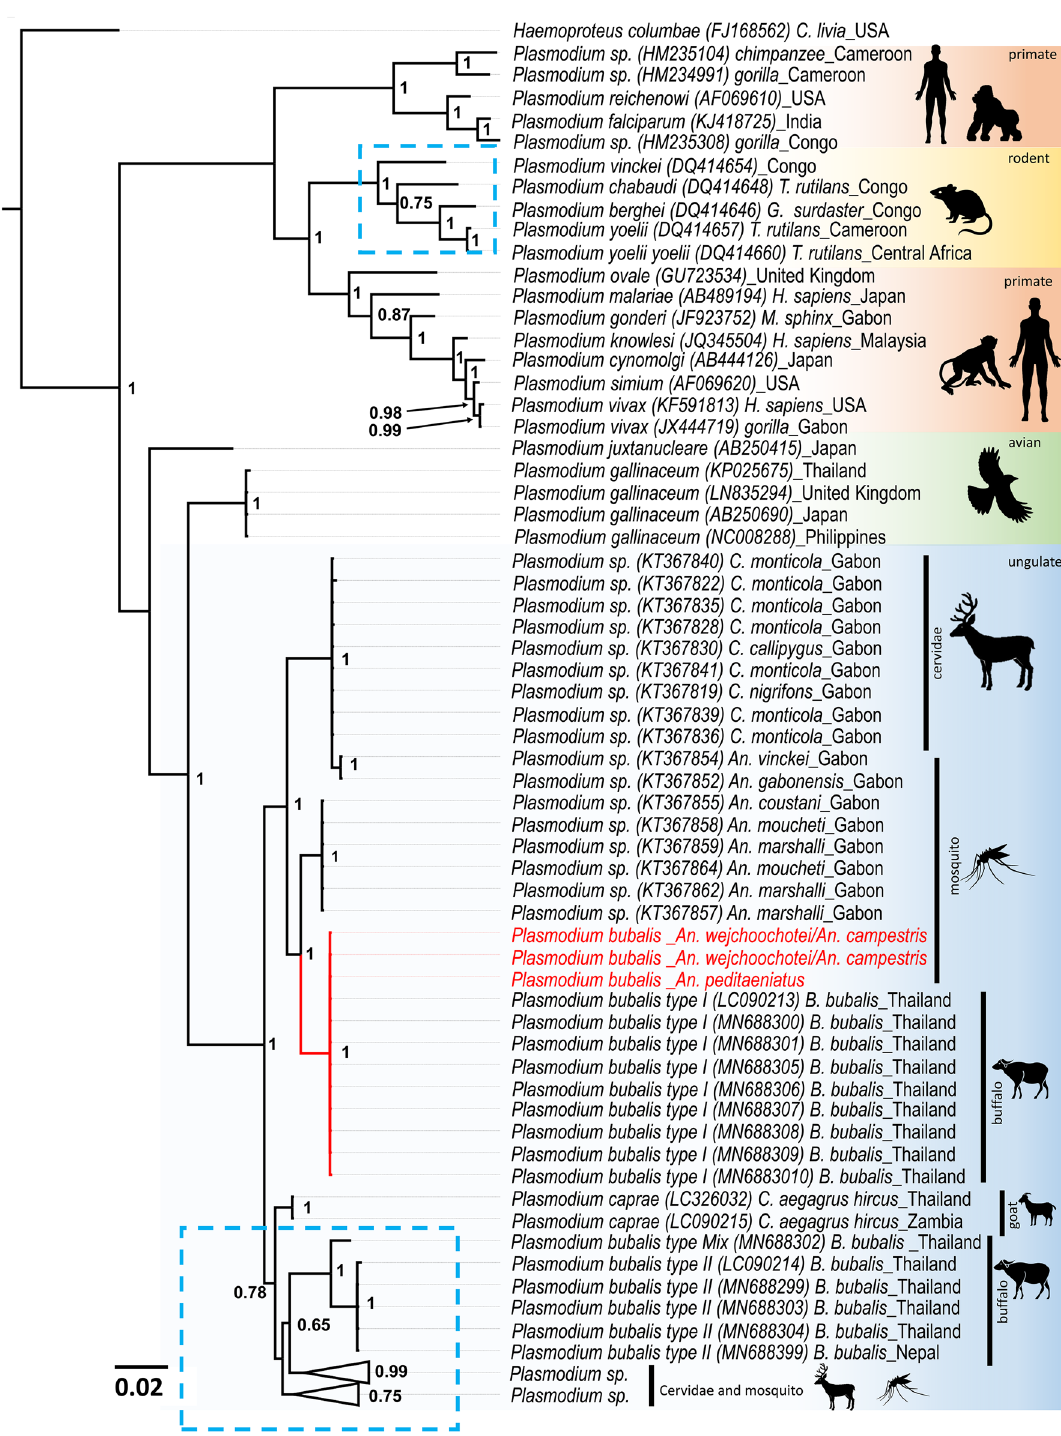
Figure 3. ( A ) Map depicting a buffalo farm in Chachoengsao for sample collection in Thailand. ( B ) The landscape of mosquito sampling sites in a buffalo farm in Chachoengsao. The images were obtained and modified from Google Earth Pro version 7.3.4.8248. The red triangle indicates blood sample collection sites, while the yellow triangle indicates mosquito sampling